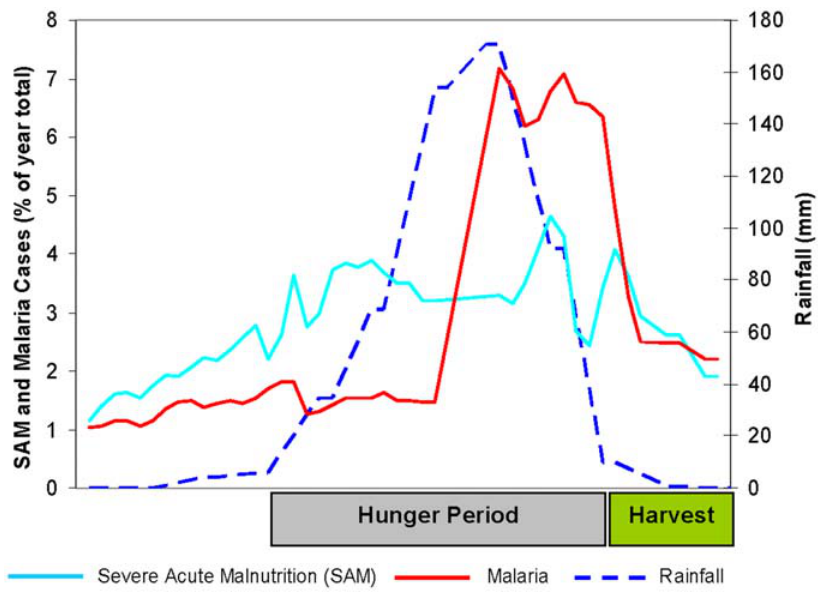
Figure 1. Seasonality in undernutrition, malaria, and rainfall in Niger, 2007 [ 13–15 ] .